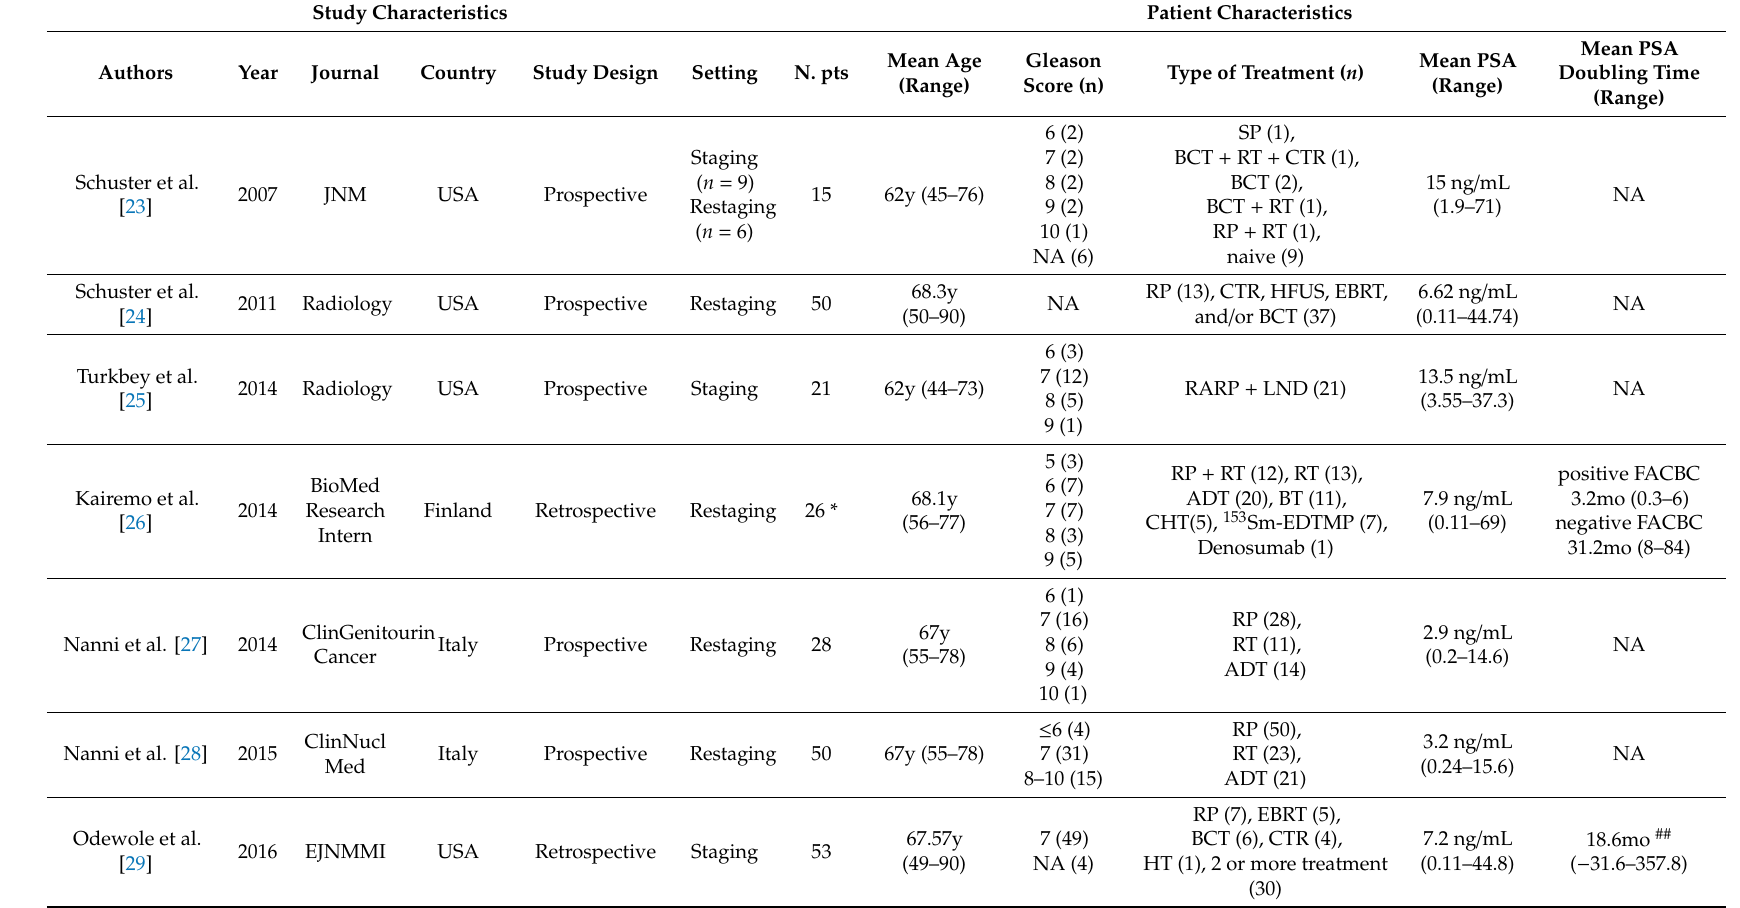
Table 1. Characteristics of selected